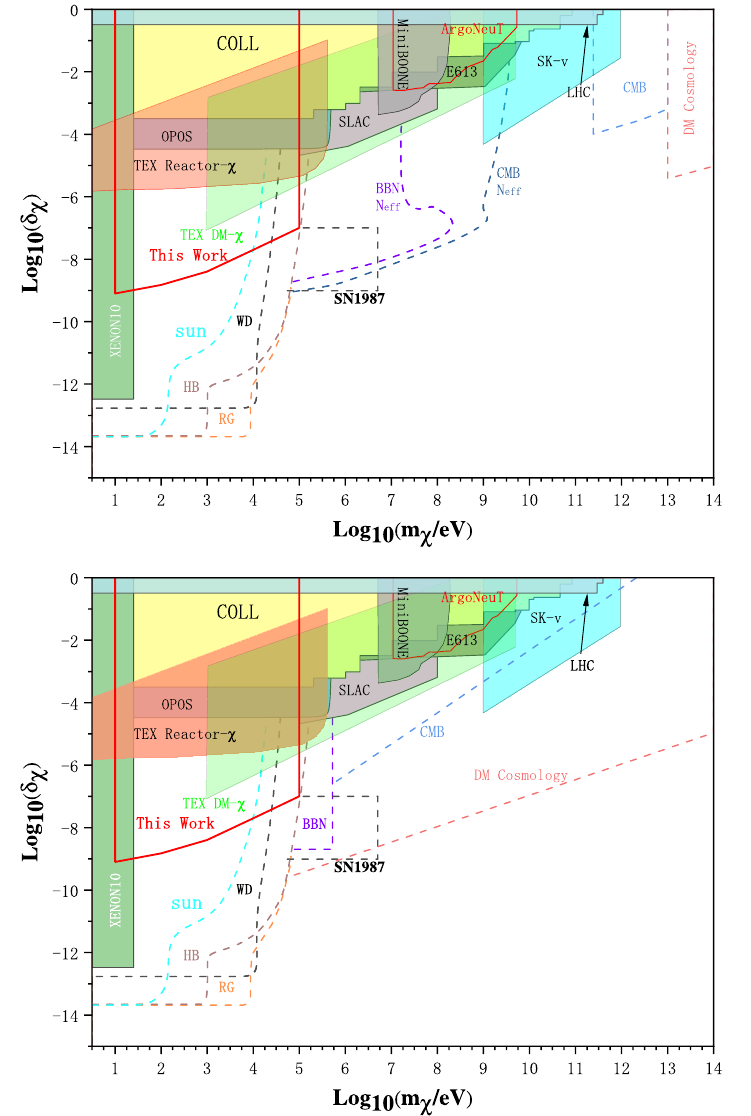
Figure 1 . The current experimental bounds for millicharged particles. In this figure, the horizontal axis labels the mass of millicharged particles m Both the horizontal axis and vertical axis are plotted employing logarithmic coordinates. The upper and lower panels correspond to two different mechanisms: upper panel shows the exclusion region for models with an additional U (1) for models with right-handed massive fermions, which are SU (2)